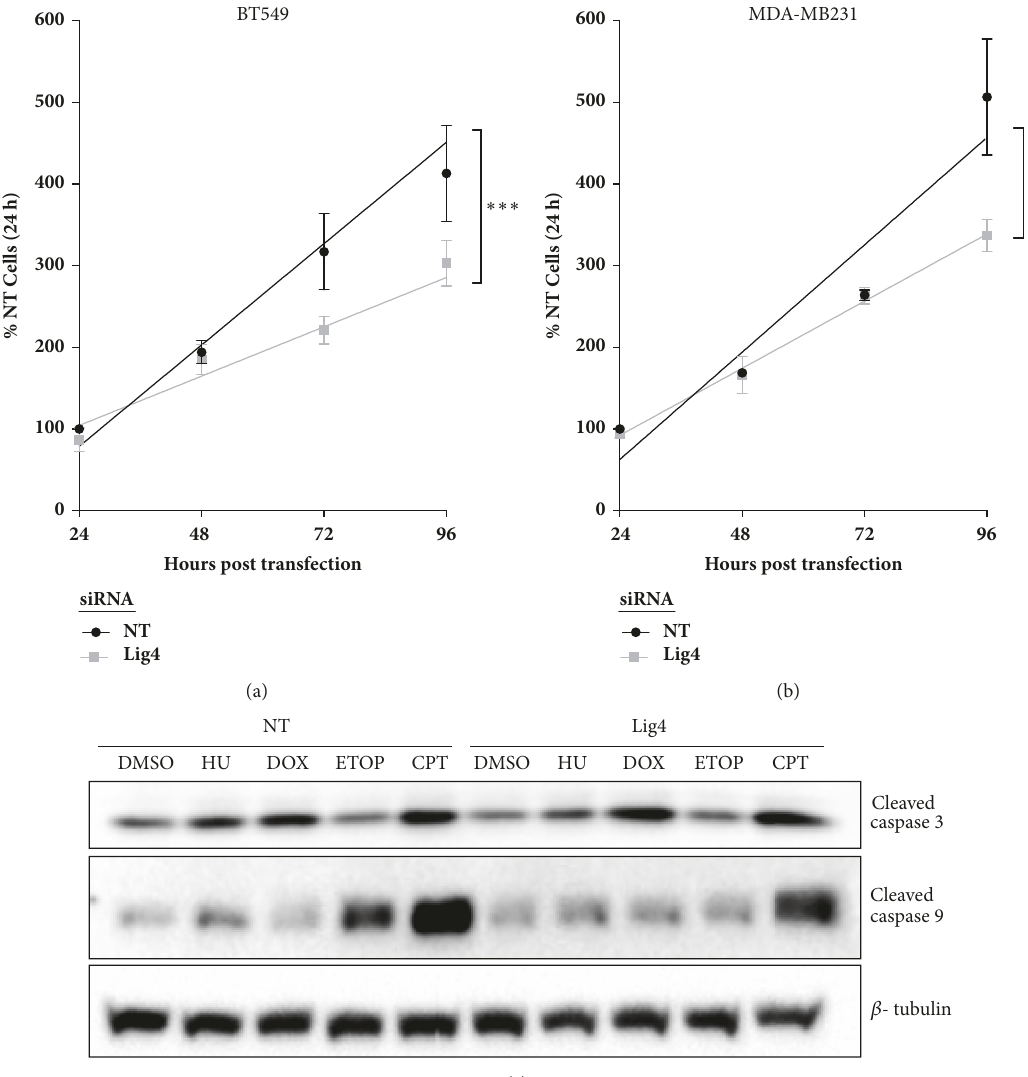
Figure 3: Lig 4 k noc kd o w n ca u ses d ecline in cell n umb ers w itho u t enhancing apoptosis. (a, b) Lig4 depleted or control (NT) cells were counted every 24 hr for up to 120 hr. Lines are the linear regression ( ∗ p < 0.05; ∗ ∗ ∗ p < 0.001, n=3). (c) Levels of apoptotic markers cleaved caspase-3 and 9 were assessed using western blot in Lig4 depleted and control cells treated with either replication toxins (1 𝜇 M doxorubicin, 2 mM hydroxyurea, 10 𝜇 M etoposide, or 0.2 𝜇 M camptothecin) or